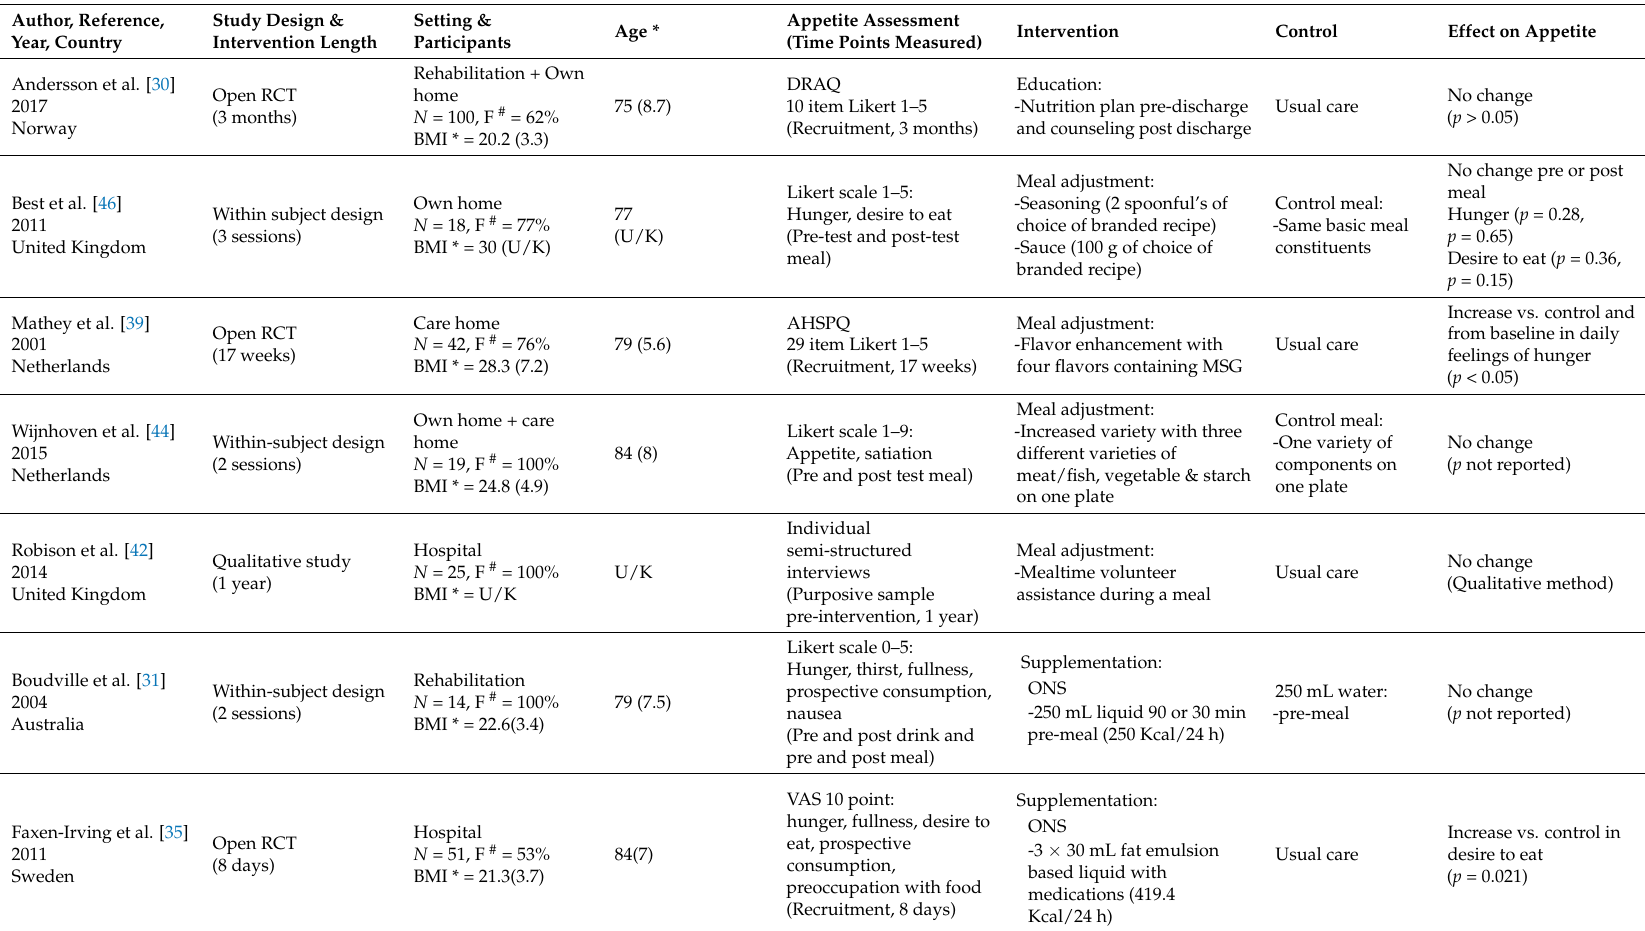
Table 2. Summary of included studies grouped by intervention